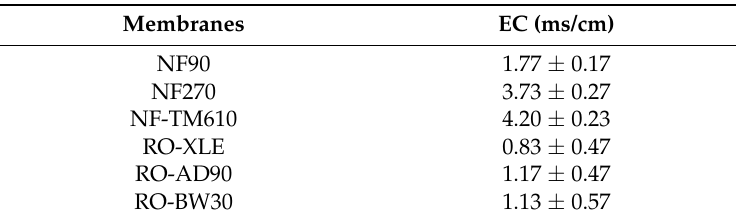
Table 5. Average EC values of NF-RO membrane